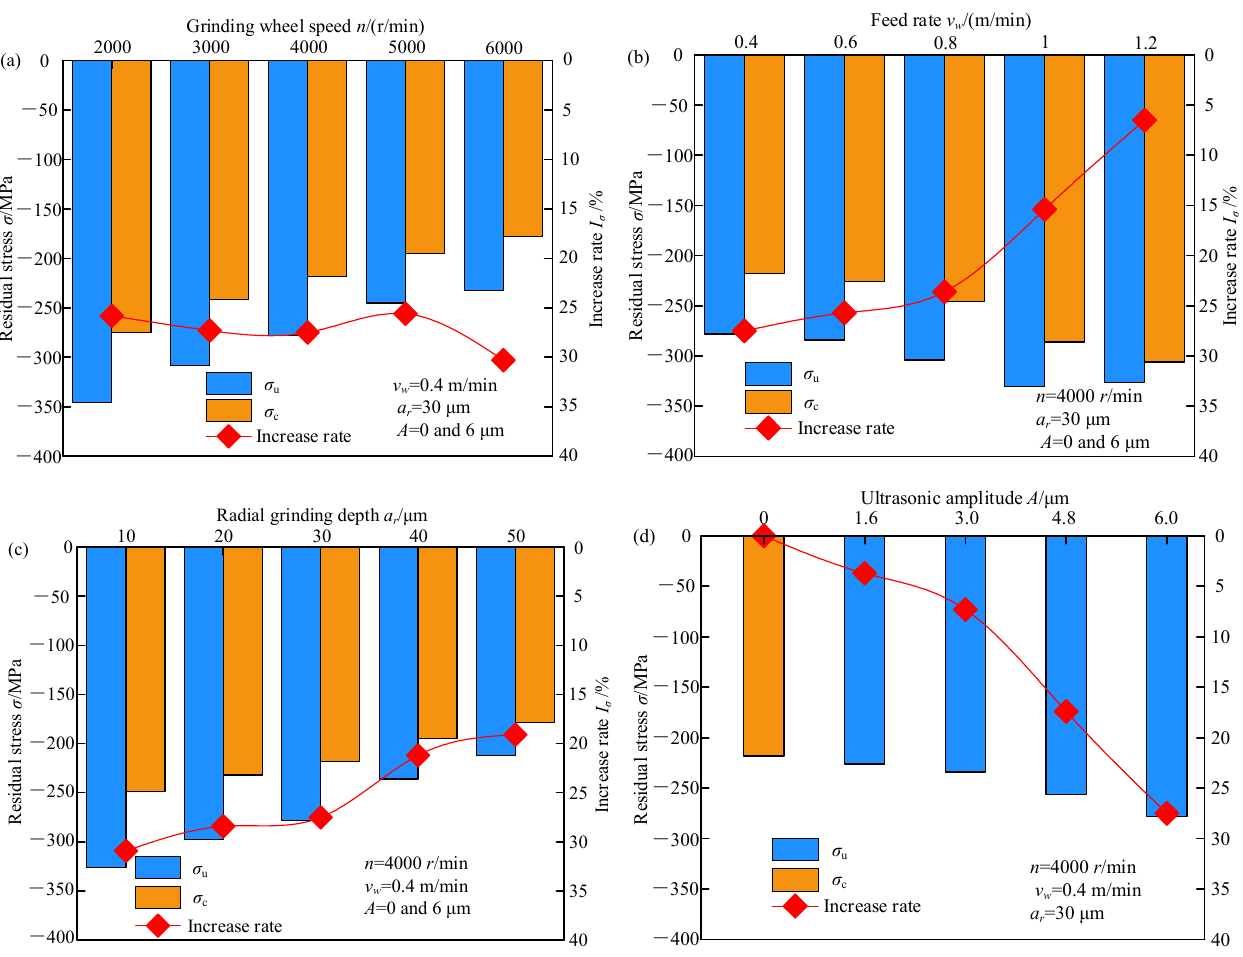
Figure 4. Effects of processing and ultrasonic parameters on the residual stress: ( a ) grinding wheel speed, ( b ) feed rate, ( c ) radial grinding depth, and ( d ) ultrasonic amplitude.